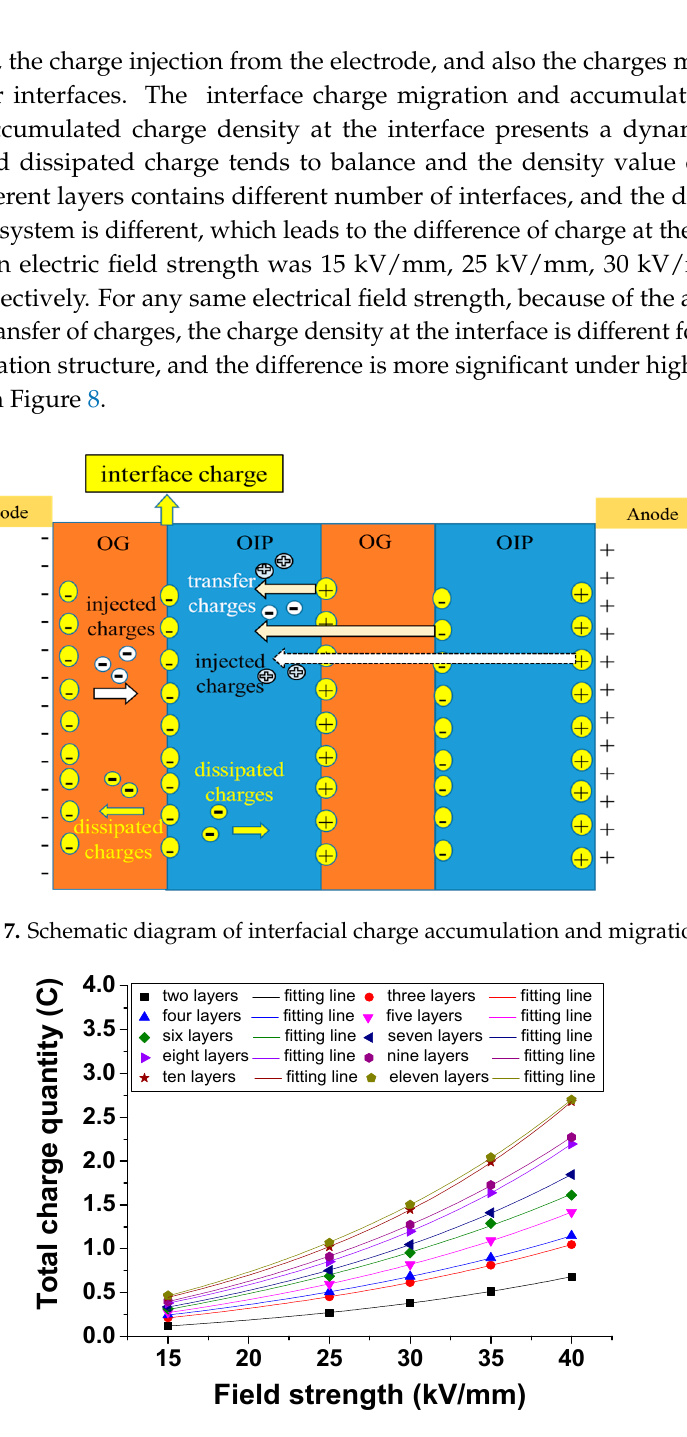
Figure 8. Total charge quantity under different electrical field strengths (20 °C) for multi-layer oil-paper insulation. Table 3. Fitting coefficients for total charge quantity at steady state (1800 s) under different electrical field strengths for multi-layer oil-paper insulation.